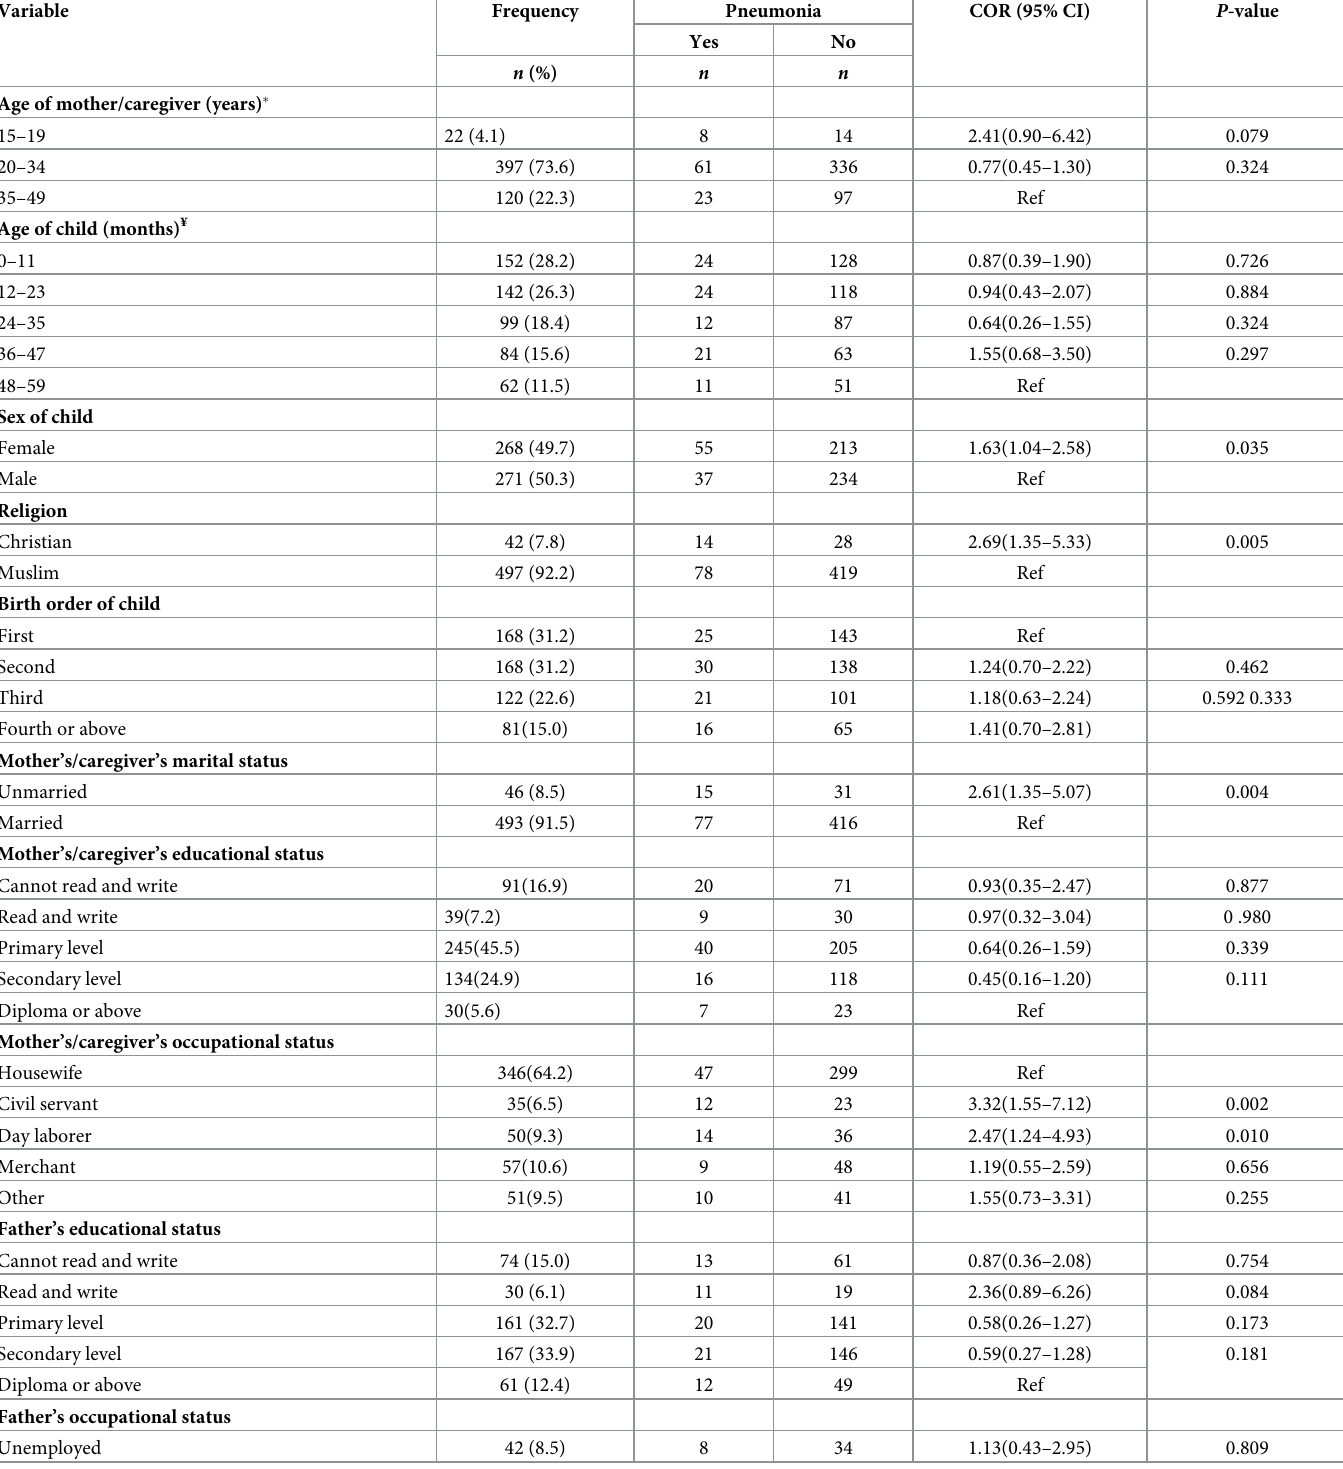
Table 1. Bivariate analysis of the association of socio-demographic factors with pneumonia among children under five in peri-urban areas of Dessie City, north- eastern Ethiopia, January—March 2019.